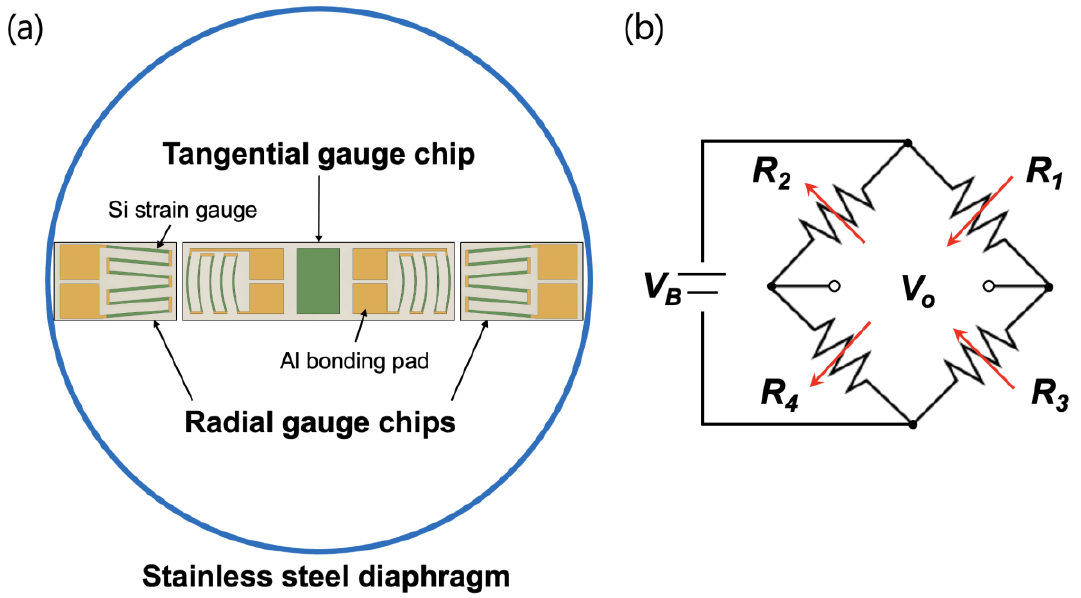
Figure 2. (a) Top view of the arrangement of silicon strain gauges on a pressure-sensing circular diaphragm. (b) Composition of a Wheatstone bridge circuit applied to a silicon strain gauge.